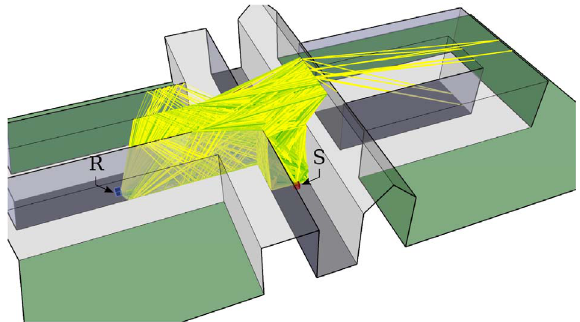
Figure 9. Visualization of all 2550 propagation paths up to 4th order from source S to receiver R . Yellow dyed segments depict stronger diffraction components, green indicates more re fl ections in the path.